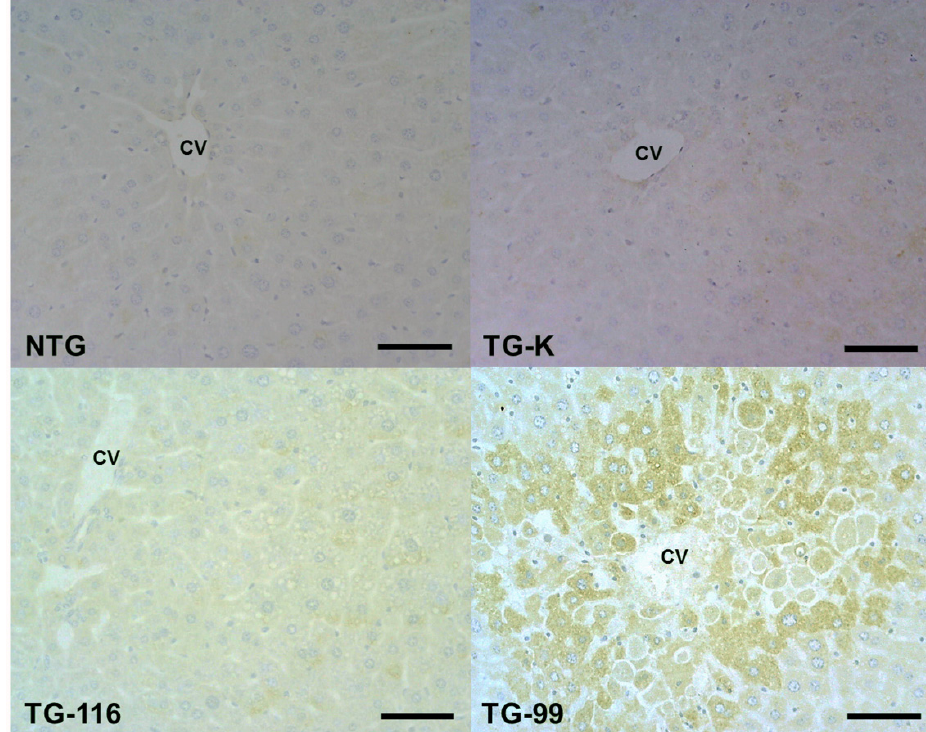
Figure 6. Immunohistochemistry staining of TGF- β 1. Scale bar = 50 μ m. CV, central